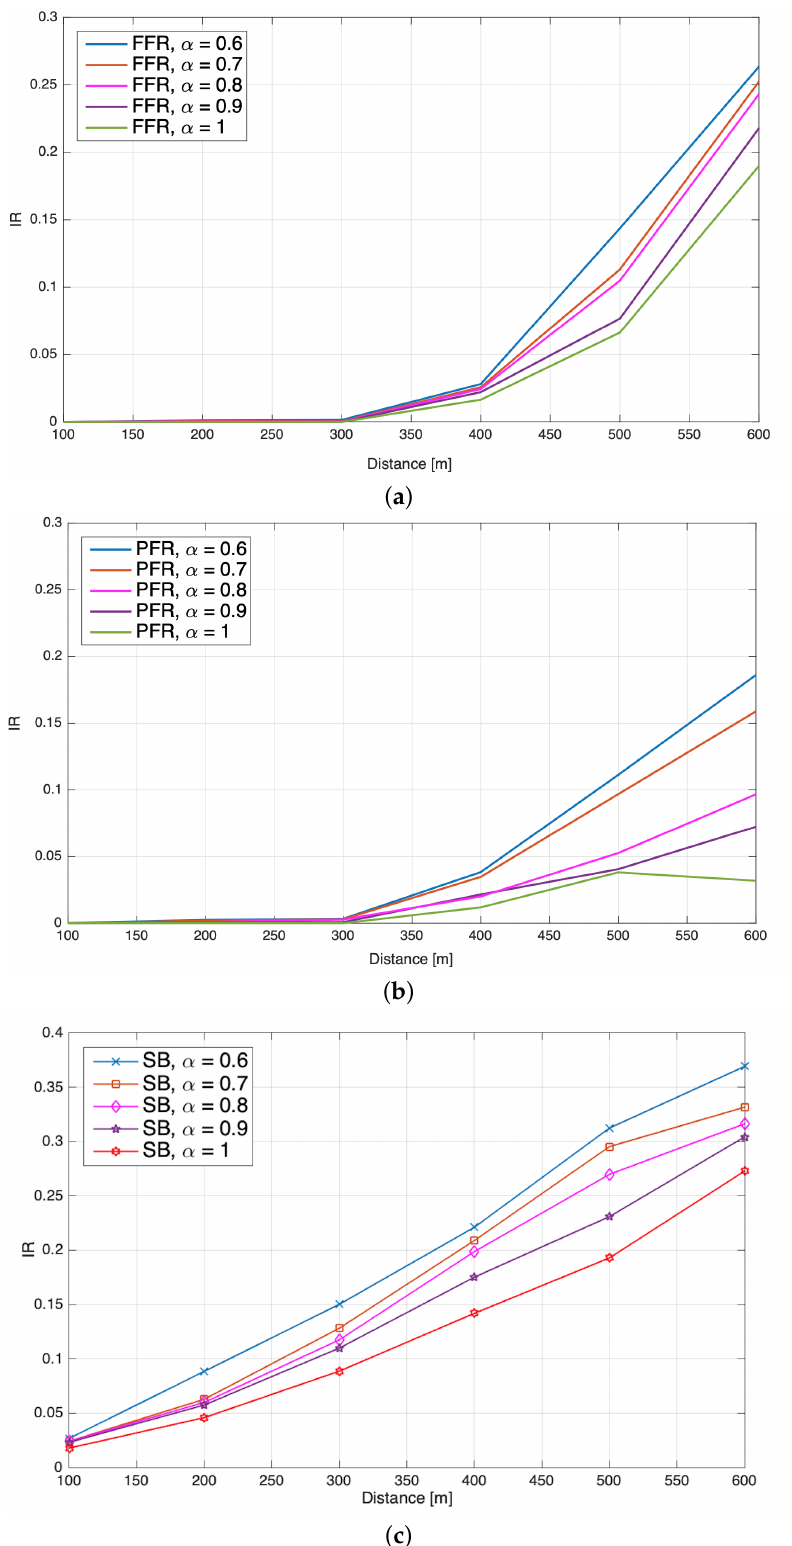
Figure 4. The interference impact of the system in partitioning techniques: ( a ) FRR and ( b ) PRR. ( c ) is the interference impact of SB when the system is without any partitioning